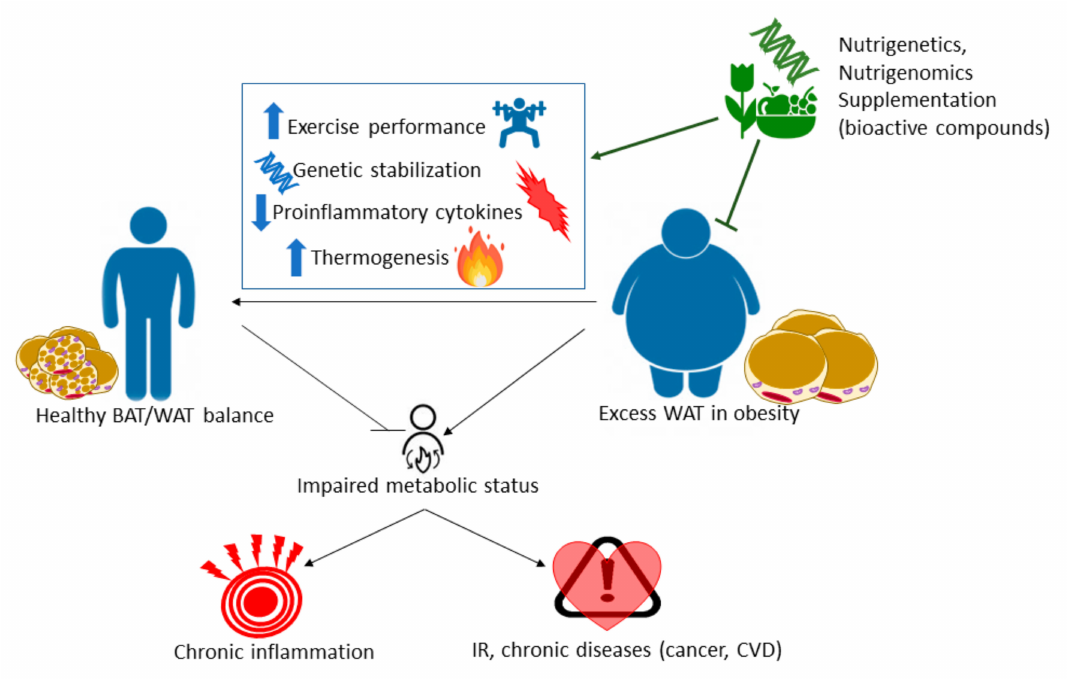
Figure 1. Precision Nutrition approach as a complementary approach in the treatment of metabolic